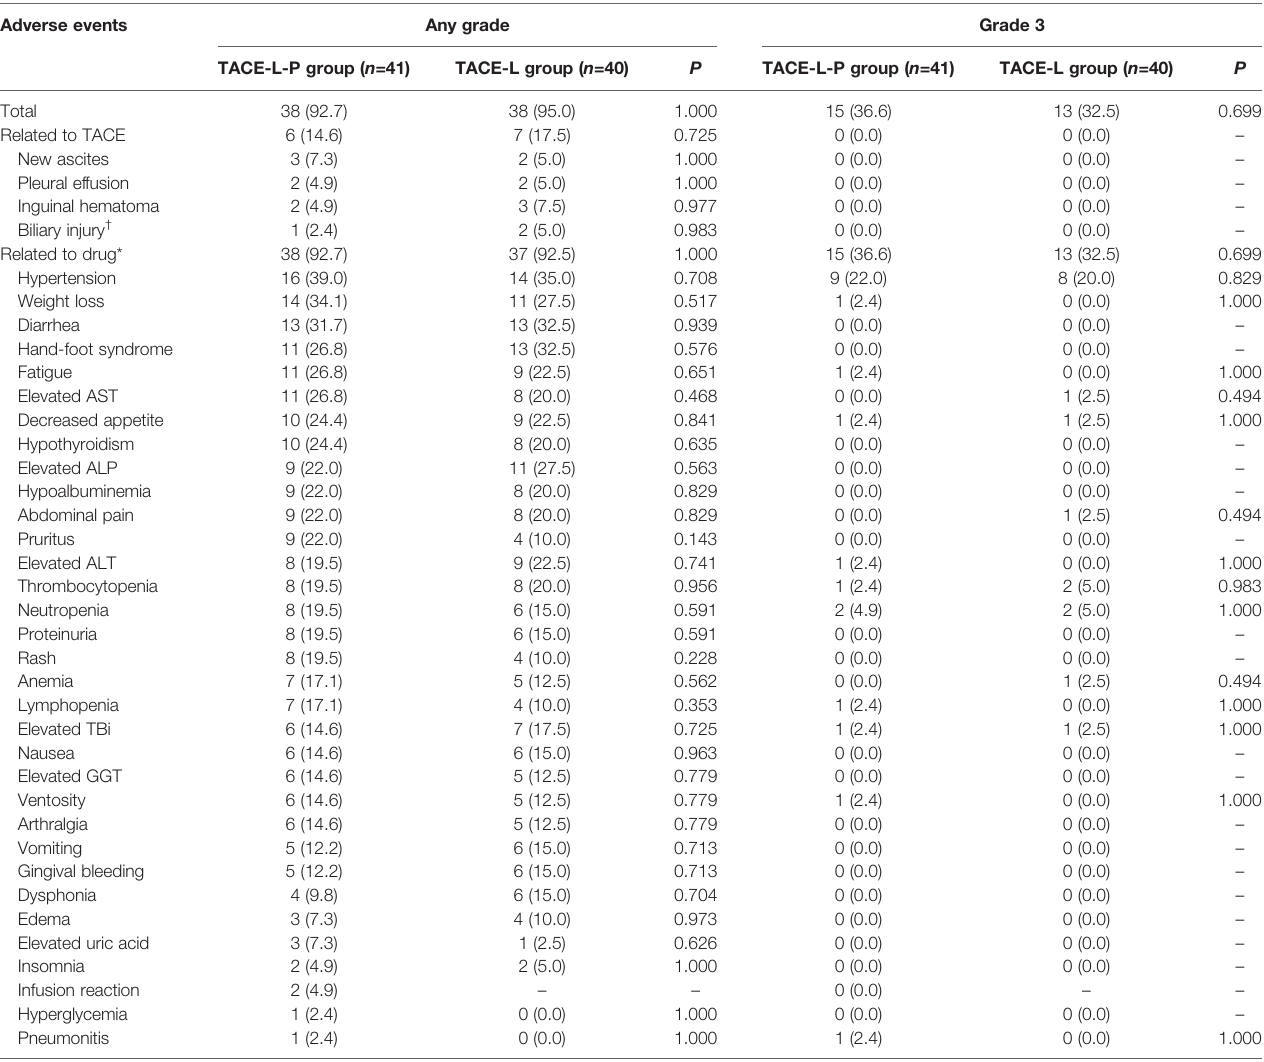
TABLE 3 | Treatment-related adverse events in the two groups. Adverse